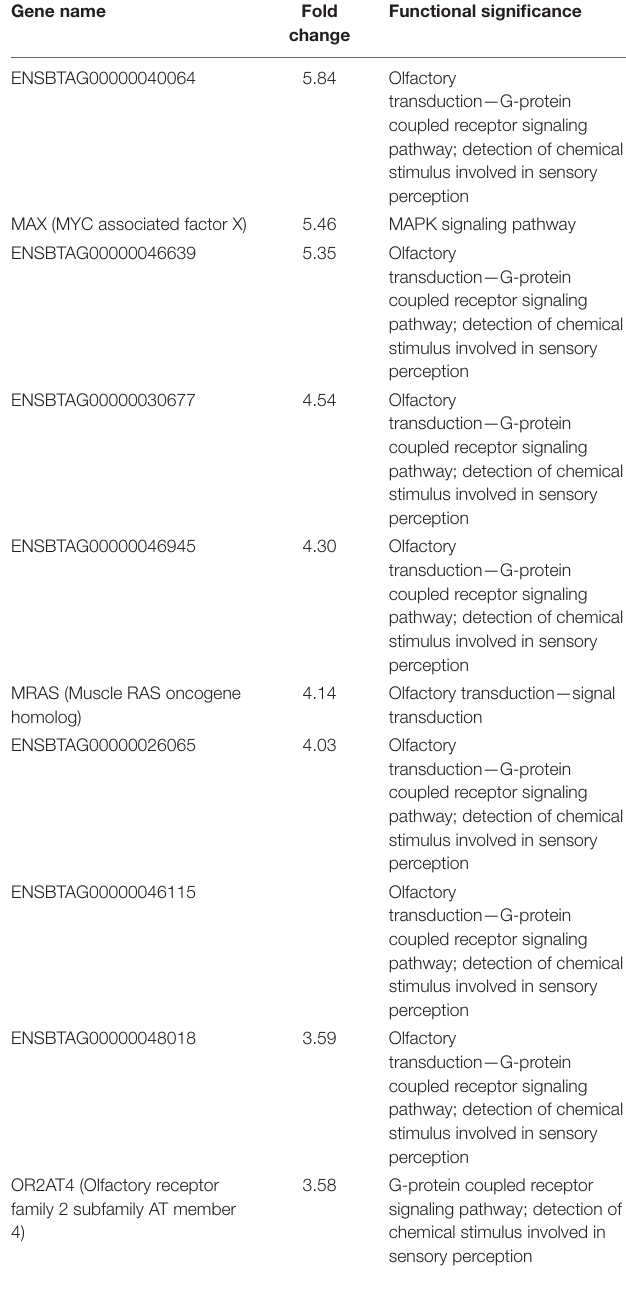
TABLE 2 | Important sperm transcripts downregulated in crossbred bull spermatozoa as compared to indigenous bull spermatozoa (from DasGupta,